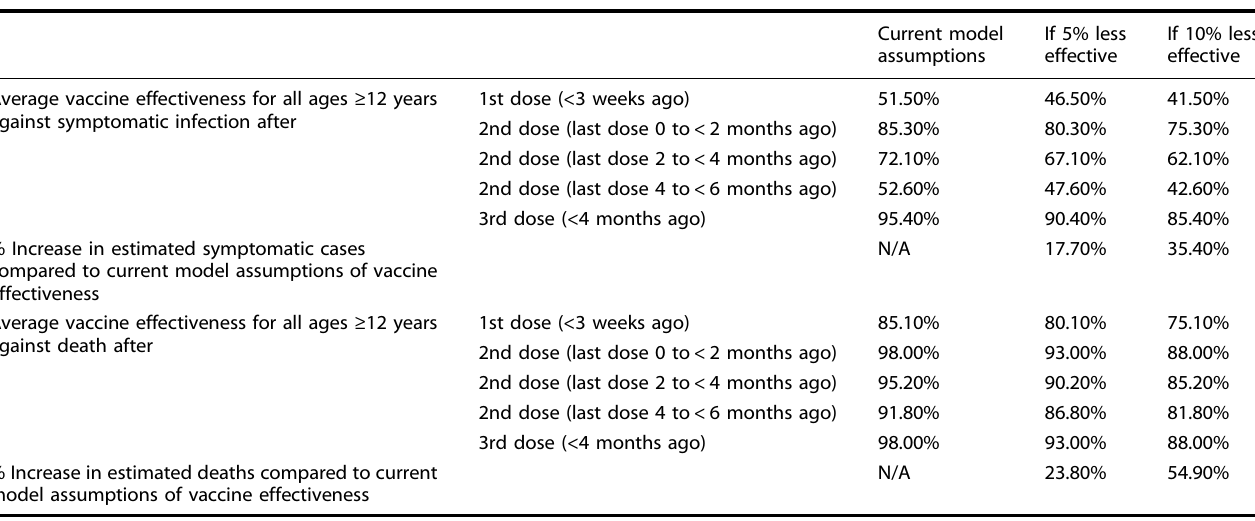
Table 3. Impact of theoretical reduction in vaccine effectiveness against delta variant on estimated deaths, assuming 5% of population of ages ≥ 12 years is unvaccinated, 5% had one dose, 60% had two doses and 30% had three